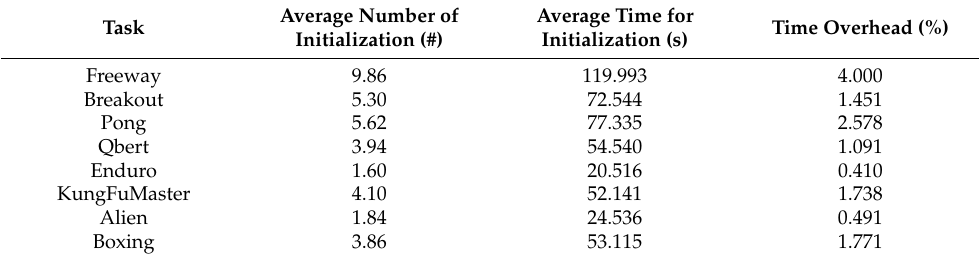
Table 5. The average number and time for initialization, and overhead ratio to the total training time by the proposed entropy-aware model